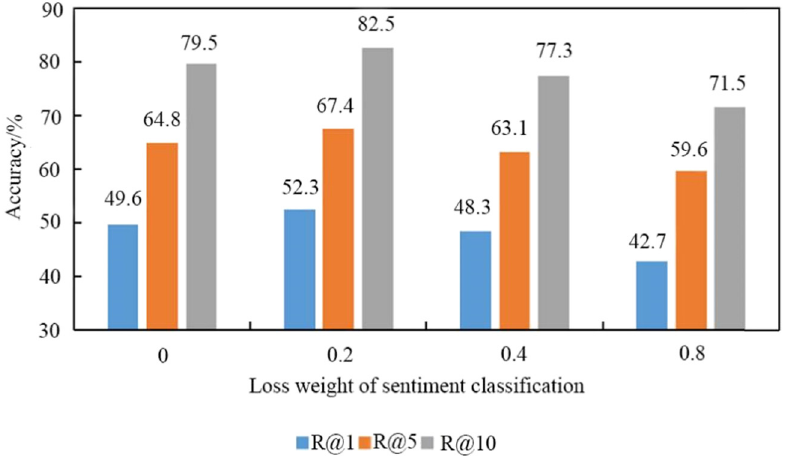
Figure 3: Accuracy of the improved music visualization algorithm under di ff erent loss weights of sentiment classi fi